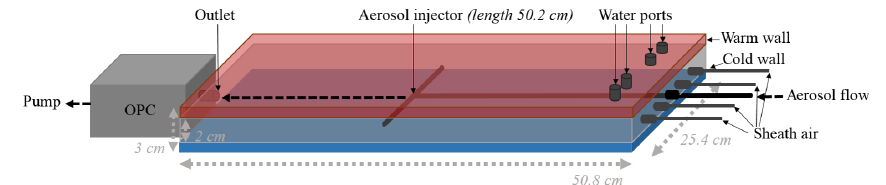
Figure 1. Schematic and outer dimensions of HINC (main